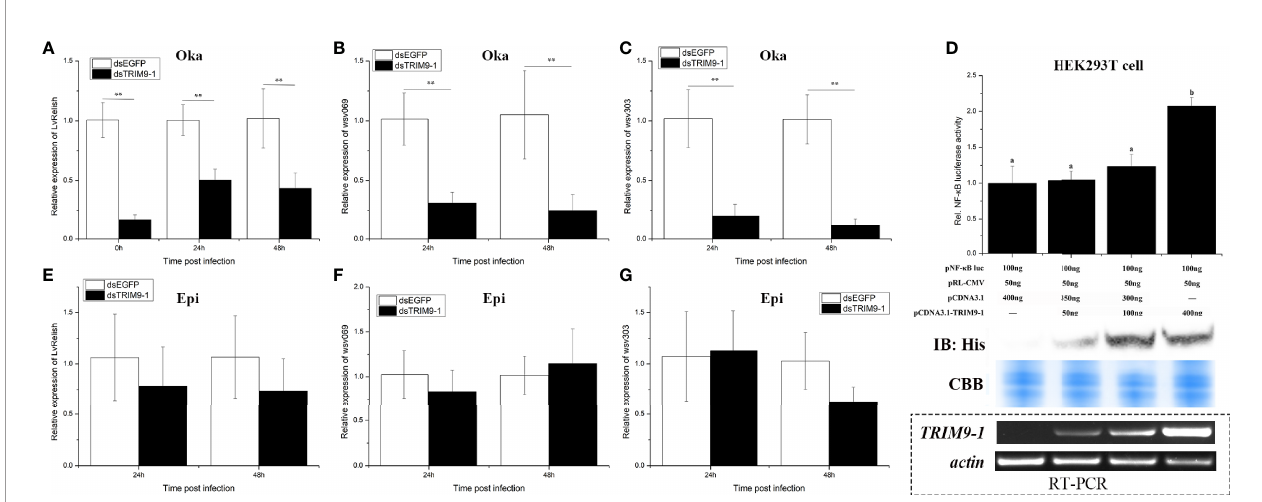
FIGURE 3 | LvTRIM9-1 enhanced WSSV transcription through activation of the NF- k B pathway. (A – C) The relative expression level of LvRelish , wsv069 , and wsv303 in lymphoid organ at different hours after silencing of LvTRIM9-1 and WSSV infection. (D) LvTRIM9-1 activated the NF- k B promoter activity in a concentration-dependent manner. Activation was detected using dual luciferase reporter assays in human HEK293T cells. Results are displayed as the fold change from the control group. Numbers (a, b) indicate extremely signi fi cant difference ( p < 0.01) of relative luciferase activities among different groups. The expression of LvTRIM9-1 was detected by Western blotting using the anti-His antibody and RT-PCR. Blots were stained with Coomassie brilliant blue (CBB) to verify equal loading. (E – G) The relative expression level of LvRelish , wsv069 , and wsv303 in epidermis at different hours after silencing of LvTRIM9-1 and WSSV infection. dsEGFP, injected with EGFP dsRNA and WSSV; dsTRIM9-1, injected with LvTRIM9-1 dsRNA and WSSV. Stars (**) indicate extremely signi fi cant differences ( p < 0.01) of the gene expression levels between dsEGFP- and dsLvTRIM9-1-treated groups. All assays described above were biologically repeated for three